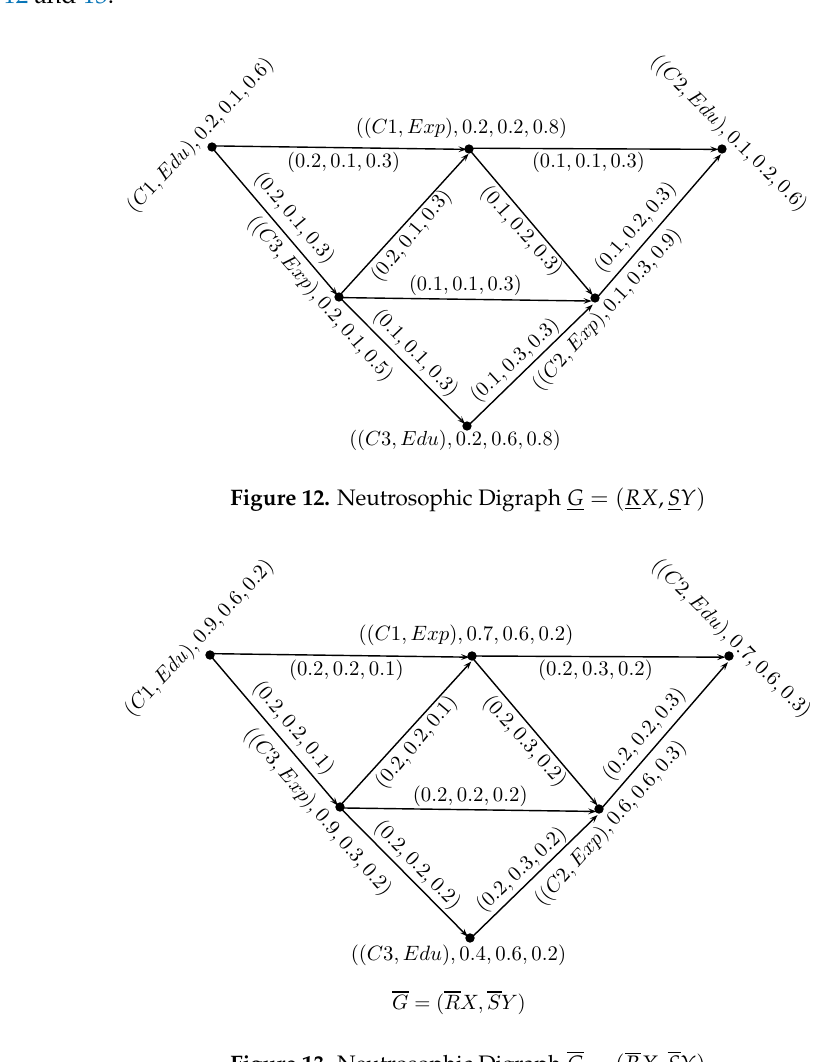
Figure 13: Neutrosophic Digraph G = ( RX,SY )